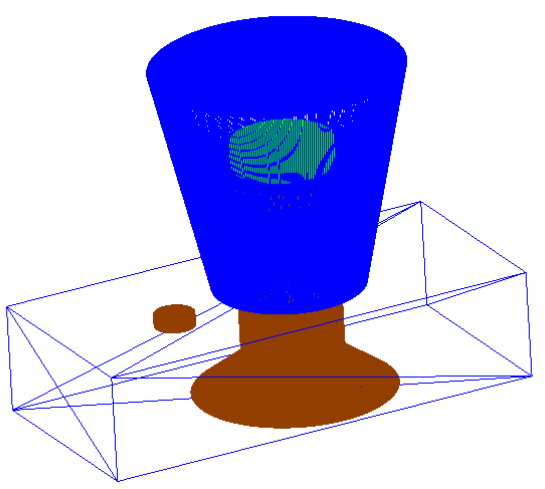
Figure 2. Microwave plasma torch parametrized model, including the rectangular waveguide, the doorknob transition with the plasma column at the top, and a tuning stub and the processing region (truncated cone).